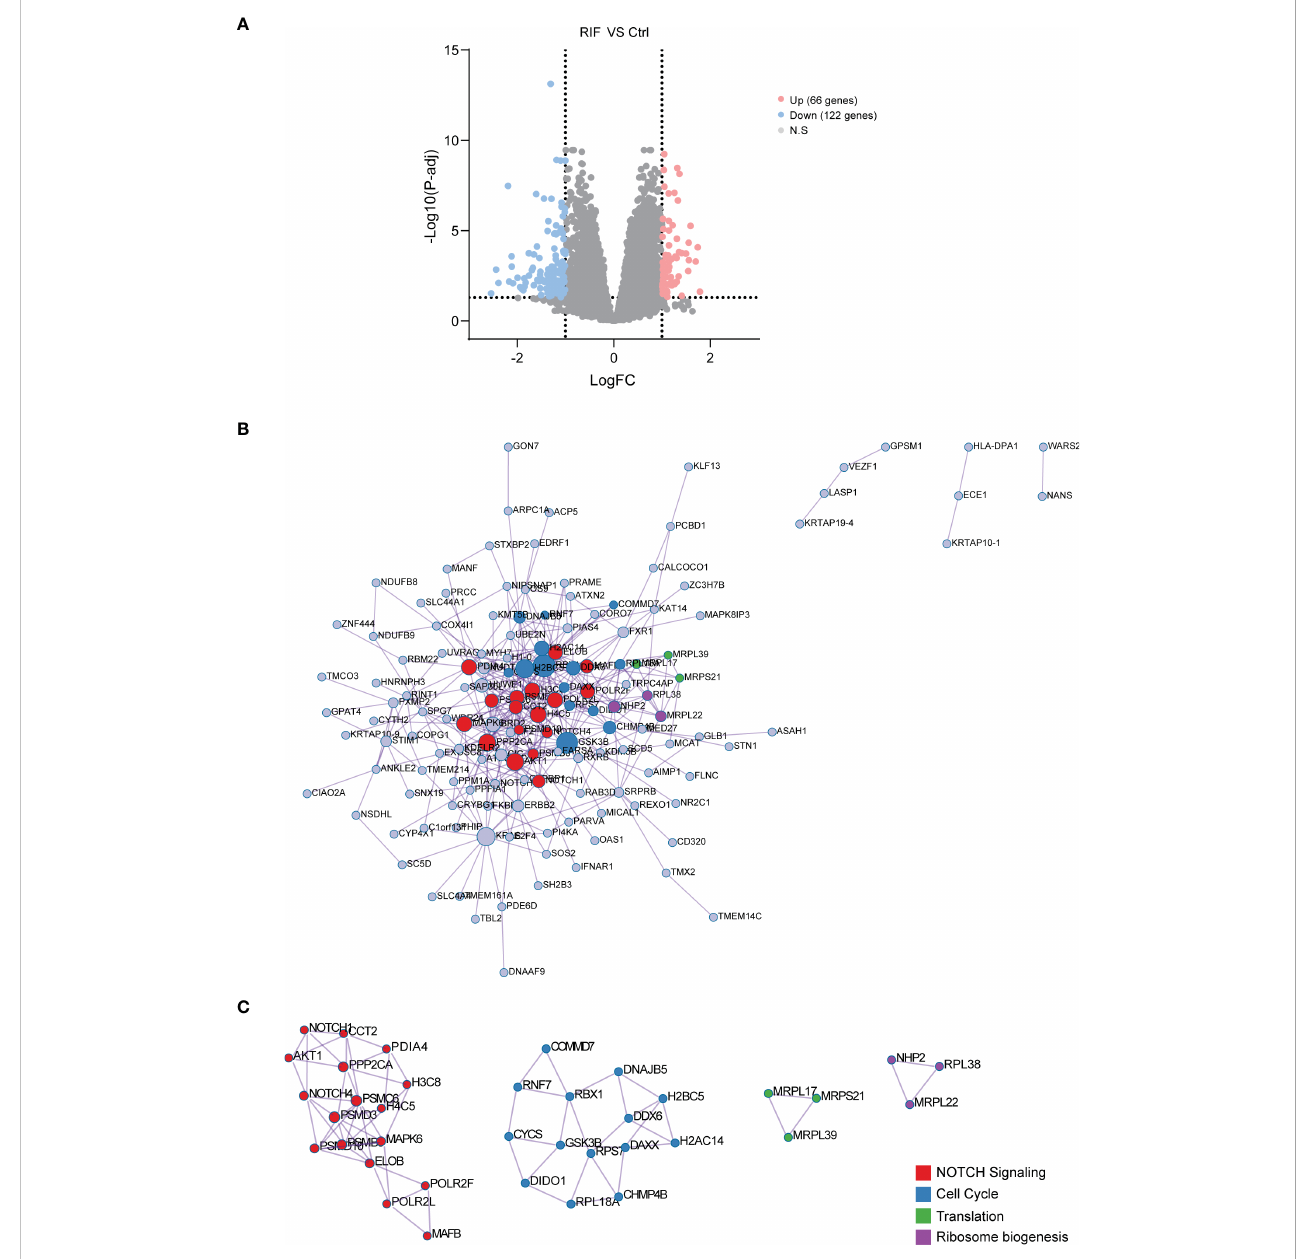
FIGURE 2 Identi fi cation, PPI Network and Module Analysis of DEGs. (A) The 188 DEGs were visualized by volcano map. (B) PPI network constructed with the DEGs from GSE103465, and GSE111974 datasets. (C) The signi fi cant module identi fi ed from the PPI network using the molecular complex detection (MCODE) method with a score of ≥ 5.0. Different nodes ’ color present different